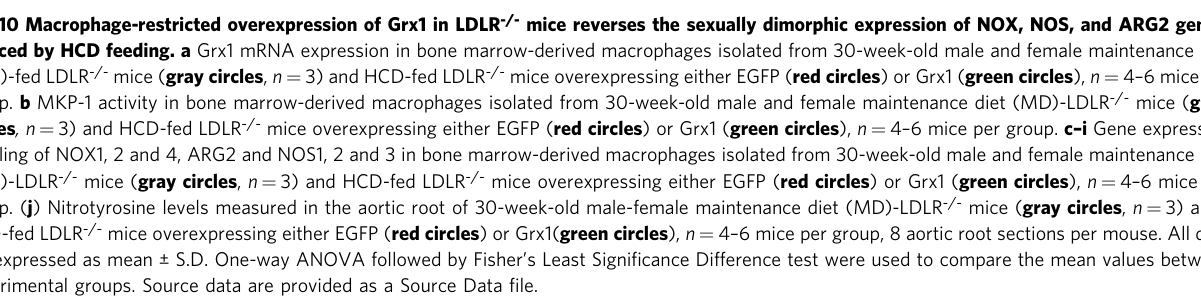
Fig. 10 Macrophage-restricted overexpression of Grx1 in LDLR -/- mice reverses the sexually dimorphic expression of NOX, NOS, and ARG2 genes induced by HCD feeding. a Grx1 mRNA expression in bone marrow-derived macrophages isolated from 30-week-old male and female maintenance diet (MD)-fed LDLR -/- mice ( gray circles , n = 3) and HCD-fed LDLR -/- mice overexpressing either EGFP ( red circles ) or Grx1 ( green circles ), n = 4 – 6 mice per group. b MKP-1 activity in bone marrow-derived macrophages isolated from 30-week-old male and female maintenance diet (MD)-LDLR -/- mice ( gray circles , n = 3) and HCD-fed LDLR -/- mice overexpressing either EGFP ( red circles ) or Grx1 ( green circles ), n = 4 – 6 mice per group. c – i Gene expression pro fi ling of NOX1, 2 and 4, ARG2 and NOS1, 2 and 3 in bone marrow-derived macrophages isolated from 30-week-old male and female maintenance diet (MD)-LDLR -/- mice ( gray circles , n = 3) and HCD-fed LDLR -/- mice overexpressing either EGFP ( red circles ) or Grx1 ( green circles ), n = 4 – 6 mice per group. ( j ) Nitrotyrosine levels measured in the aortic root of 30-week-old male-female maintenance diet (MD)-LDLR -/- mice ( gray circles , n = 3) and HCD-fed LDLR -/- mice overexpressing either EGFP ( red circles ) or Grx1( green circles ), n = 4 – 6 mice per group, 8 aortic root sections per mouse. All data are expressed as mean ± S.D. One-way ANOVA followed by Fisher ’ s Least Signi fi cance Difference test were used to compare the mean values between experimental groups. Source data are provided as a Source Data fi